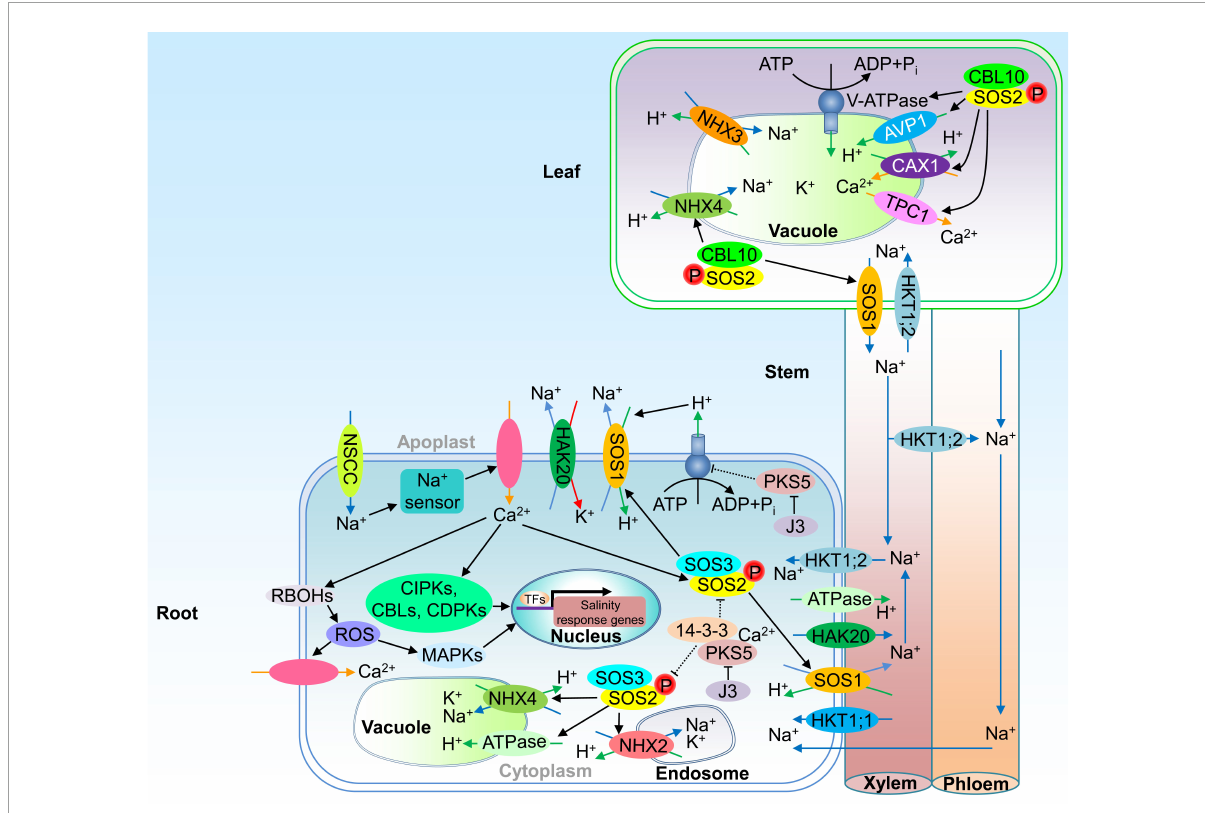
FIGURE1 Schematic overview of sodium uptake into tomato roots and transport into leaves. Na + ions enter tomato root cells primarily through NSCC pathway. Na + entering the cell is sensed by a yet undetermined sensory mechanism. Subsequently, Ca 2 + , ROS, and hormone (not shown) signaling pathways are activated. Ca 2 + induces ROS production by RBOHs and ROS induces Ca 2 + import. As one part of the Ca 2 + -signaling pathway, CIPKs, CBLs, and CDPKs become active and alter the global transcriptional profile in the nucleus. MAPKs activated by Ca 2 + -ROS- signaling pathway also transduce downstream gene transcription in the nucleus. These early signaling pathways result in activation of detoxification mechanisms. Cytosolic Ca 2 + ions activate SOS3. SOS2 regulates ATPase, NHX2 and NHX4, increasing Na + /H + and K + /H + anti-transport activity in root vacuole and endosome. The kinase activity of SOS2 is negatively regulated by 14-3-3 proteins, and the inhibition on SOS2 is released by the Ca 2 + -mediated binding of PKS5 with 14-3-3. SOS1 activated by SOS2-SOS3 heterologous kinase complex is responsible for extruding Na + out the root and partitioning Na + in organs. J3 inhibits PKS5 kinase activity, activating the activity of PM H + -ATPases and generating a proton gradient required for Na + transport of SOS1. CBL10-SOS2 complex triggers the separation of Na + into leaf vacuole and the transport of Na + ions from leaves to xylem, activates the tonoplast targets TPC1 and AVP1, maintaining an appropriate Na + /Ca 2 + ratio and V-ATPase, and promotes the proton gradient necessary to energize the Ca 2 + transport toward the vacuole through CAX1. HKT1;2 is involved in xylem Na + unloading and Na + uploading into the phloem, thus promoting Na + recirculation from shoots to roots, which can be additionally regulated by HKT1;1 in roots. HAK20 transports and regulates the homeostasis of Na + and K + . ADP, adenosine diphosphate; ATP, adenosine triphosphate; AVP1, H + -pyrophosphatase; CAX1, CATION EXCHANGER 1; CBL, calcineurin B-like protein; CDPKs, calcium-dependent protein kinases; CIPKs, CBL-interacting protein kinases; RBOHs, respiratory burst oxidase homologs; HAK, high-affinity K + transporter; HKT, high K + affinity transporter; J3, DNAJ HOMOLOG3; MAPK, mitogen-activated protein kinase; NHX, Na + /H + exchanger; NSCCs, non-selective cation channels; PKS5, PROTEIN KINASE5; ROS, reactive oxygen species; SOS, salt overly sensitive; TFs, transcription factors; TPC1, TWO-PORE CHANNEL 1. The dashed lines indicate that the negative regulatory roles are released under salt